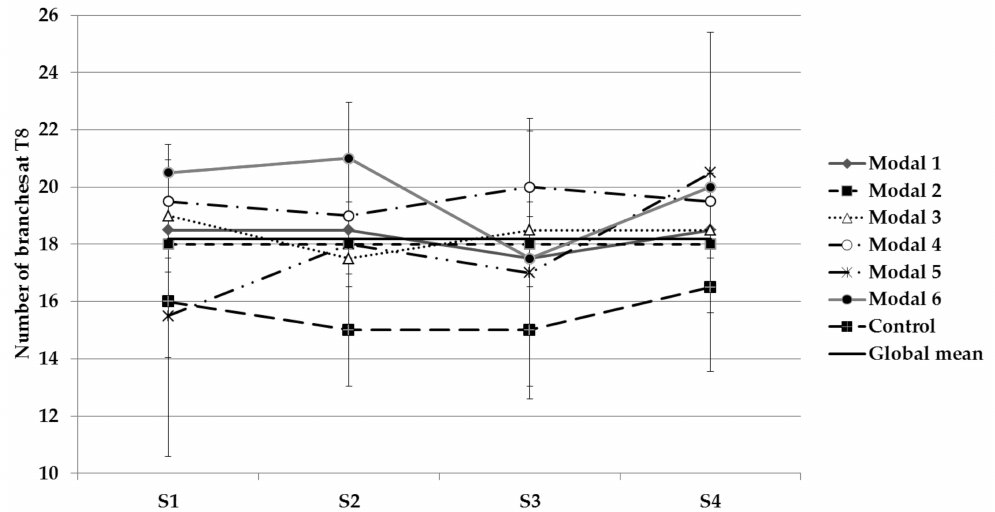
Figure 8. Graph of means of number of branches (on the vertical axis) for each modality tested according to the different substrates (on the horizontal axis), 8 weeks after planting. S1 = 100% coconut fiber; S2 = 66% coconut fiber + 33% bagasse; S3 = 50% coconut fiber + 50% bagasse; S4 = 33% coconut fiber + 66% bagasse). Modality 1 = AMF (strain IP21); modality 2 = AMF (strain